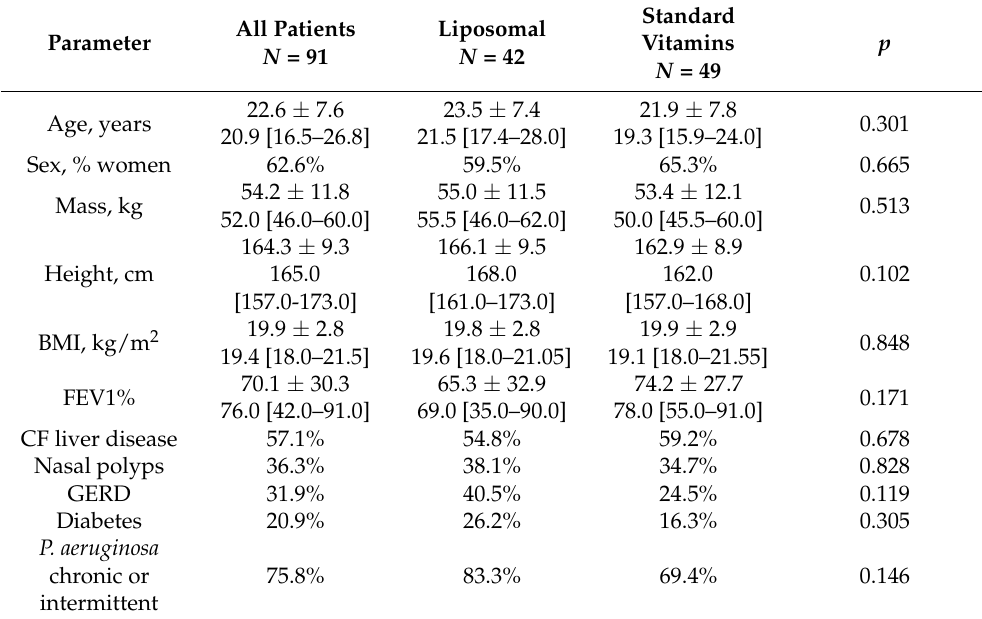
Table 2. Baseline characteristics of patients included in the trial. Mean ± SD or percentage are provided.